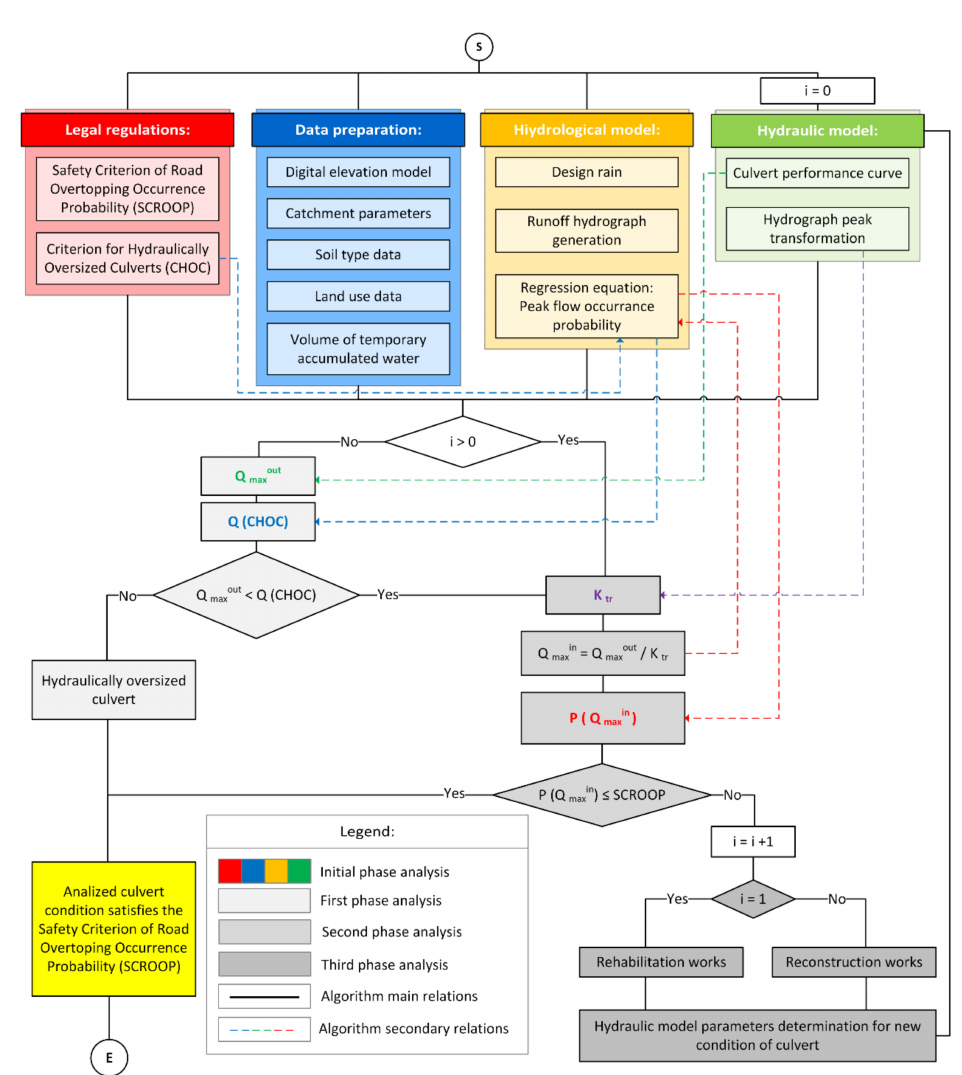
Figure 7. The algorithm for road culvert maintenance based on the overtopping occurrence probability (the CMOOP